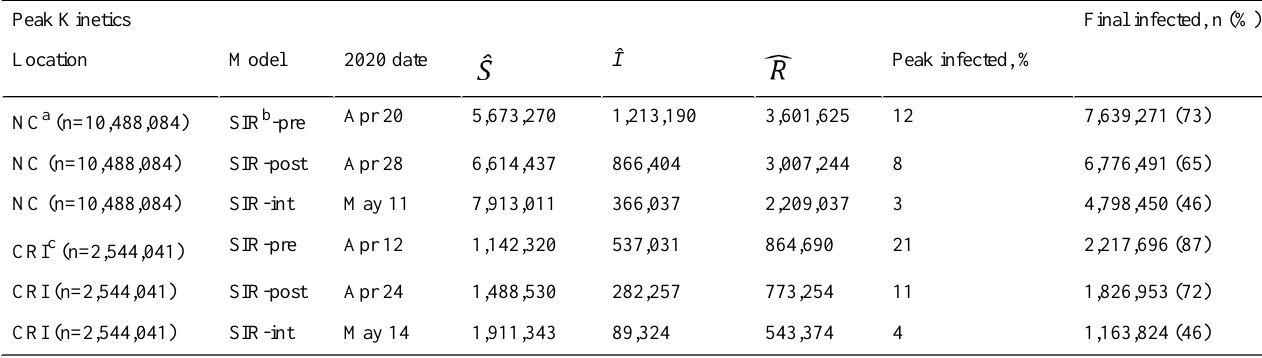
Table 3. Summary table describing infection under three different models in NC and the